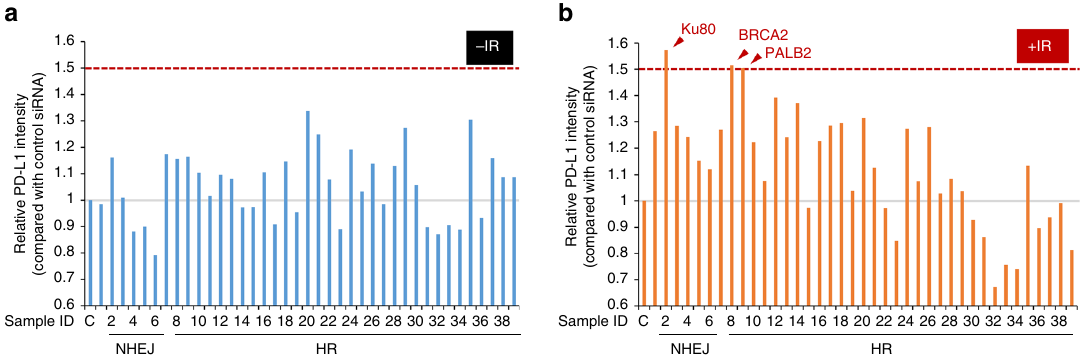
Fig. 3 Identi fi cation of factors in fl uencing PD-L1 upregulation after IR. a , b PD-L1 intensity relative to that of control siRNA cells was examined after IR by immunoblotting. A raw image of the immunoblotting is shown in Supplementary Fig. 5. U2OS cells were exposed to a Dharmacon siRNA pool containing four distinct oligonucleotides. PD-L1 was examined 48 h after (Fig. 4a). In a clinical trial, a PARP inhibitor (PARPi) has been